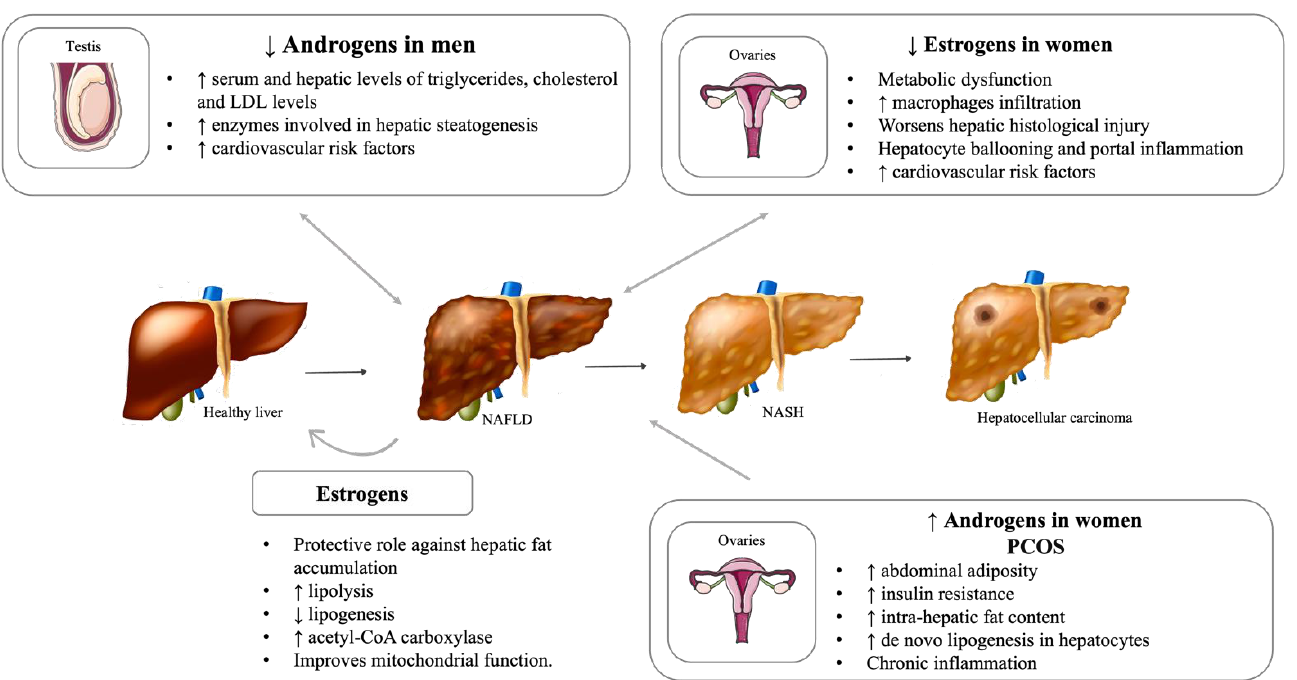
Figure 4. Sexual hormones and NAFLD. NAFLD: Nonalcoholic fatty liver disease; NASH: Nonalco- holic steatohepatitis; PCOS: Polycystic ovary syndrome. [Viktoriia Kasyanyuk] © https://www.123rf. com/ (accessed on 22 February 2022) and Servier Medical Art by Servier.